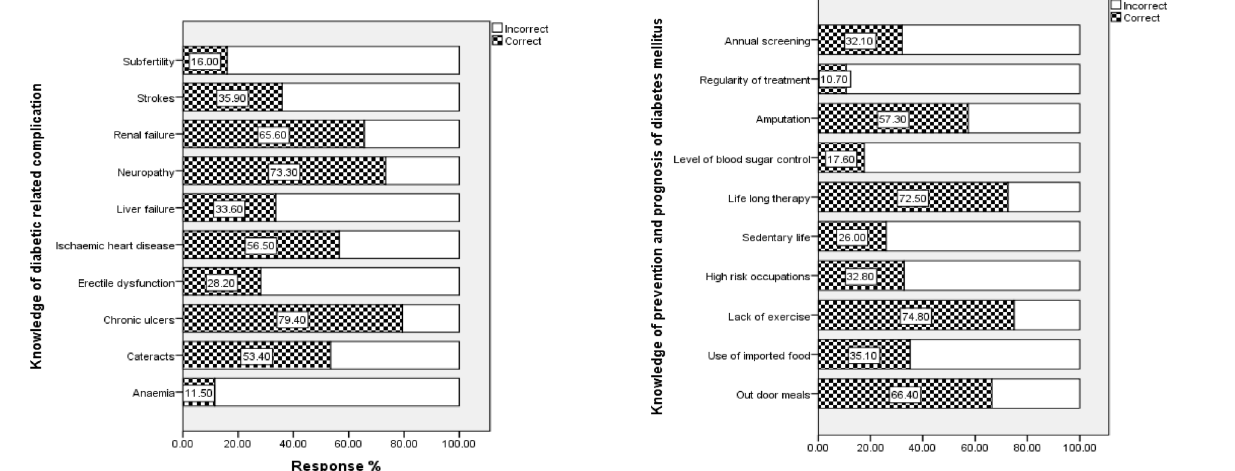
Figure 3B: Awareness and knowledge of prevention and prognosis of diabetes